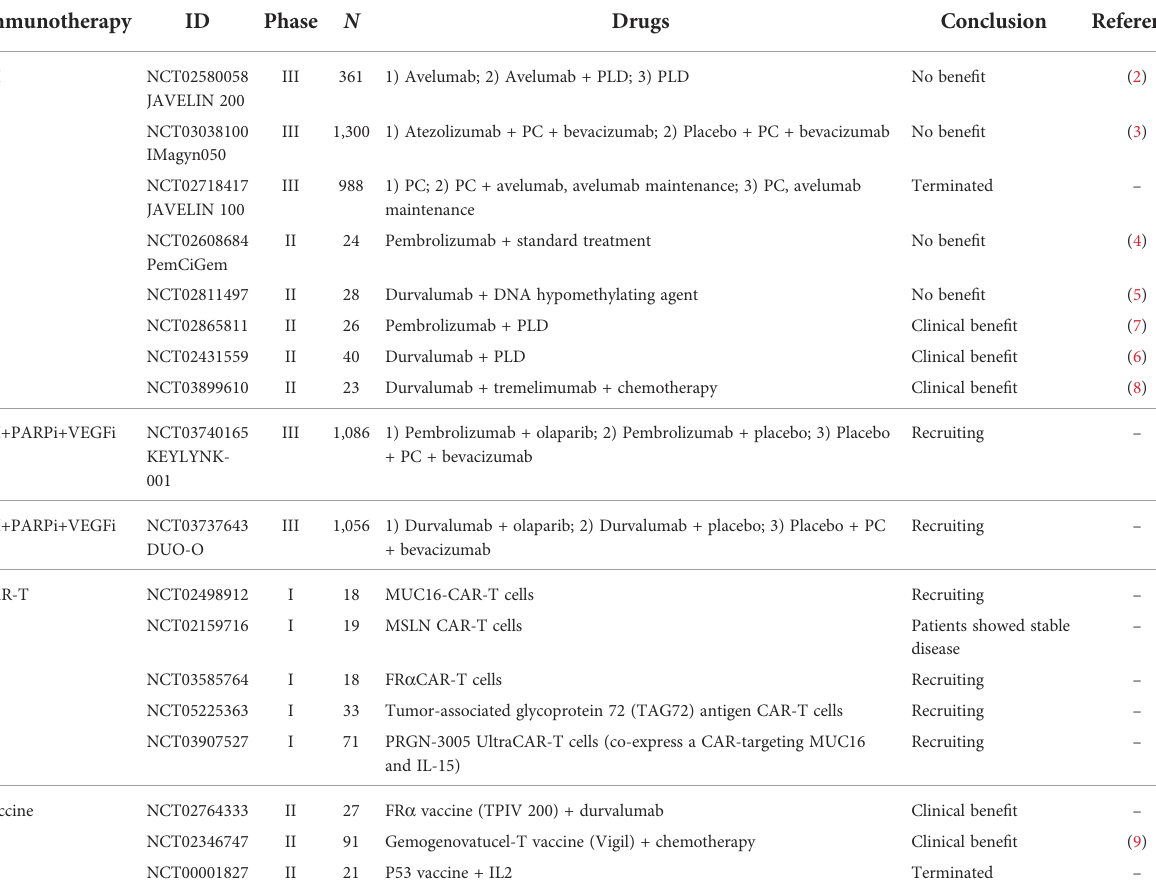
TABLE 1 Clinical trials of immunotherapy in ovarian cancer.